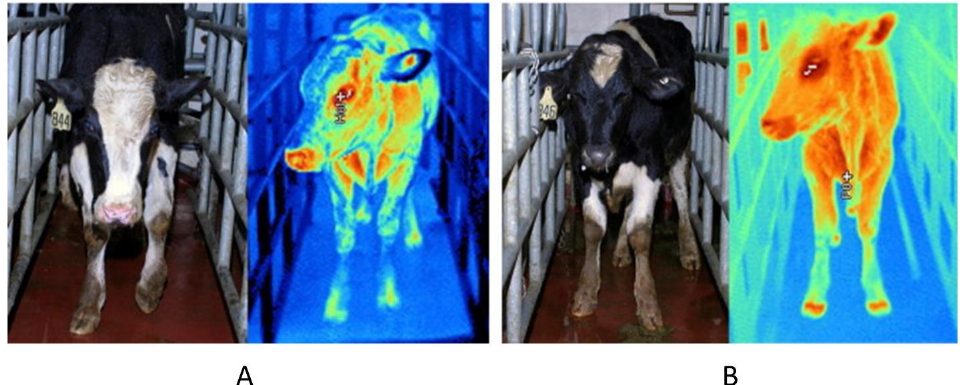
Figure 3. IRT imaging technology in early diagnosis of animal diseases. Infrared images of cattle without ( A ) and with ( B ) fever and viremia at 24 h post challenge, before vesicular lesions were observed. Reprinted with permission from Ref. [75]. Copyright Elsevier and copyright clearance center.